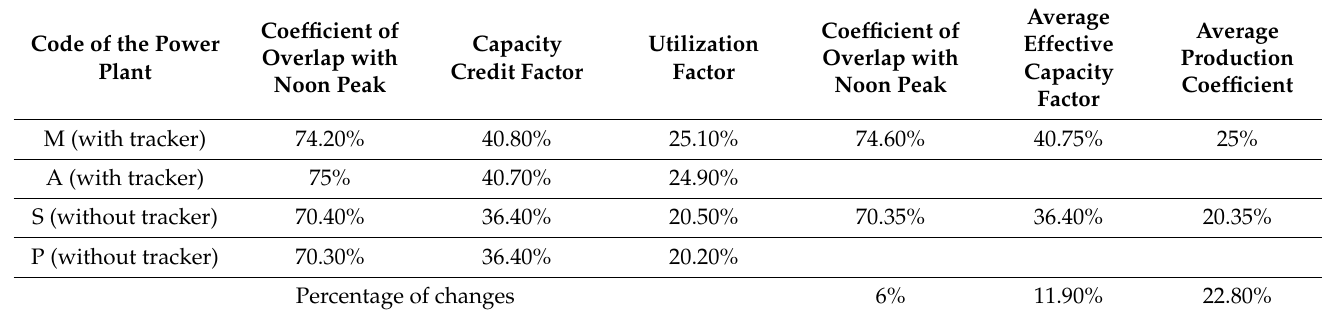
Table 6. A comparison between four power plants’ capacity factor, capacity credit and peak time overlap in power plants with/out tracker.